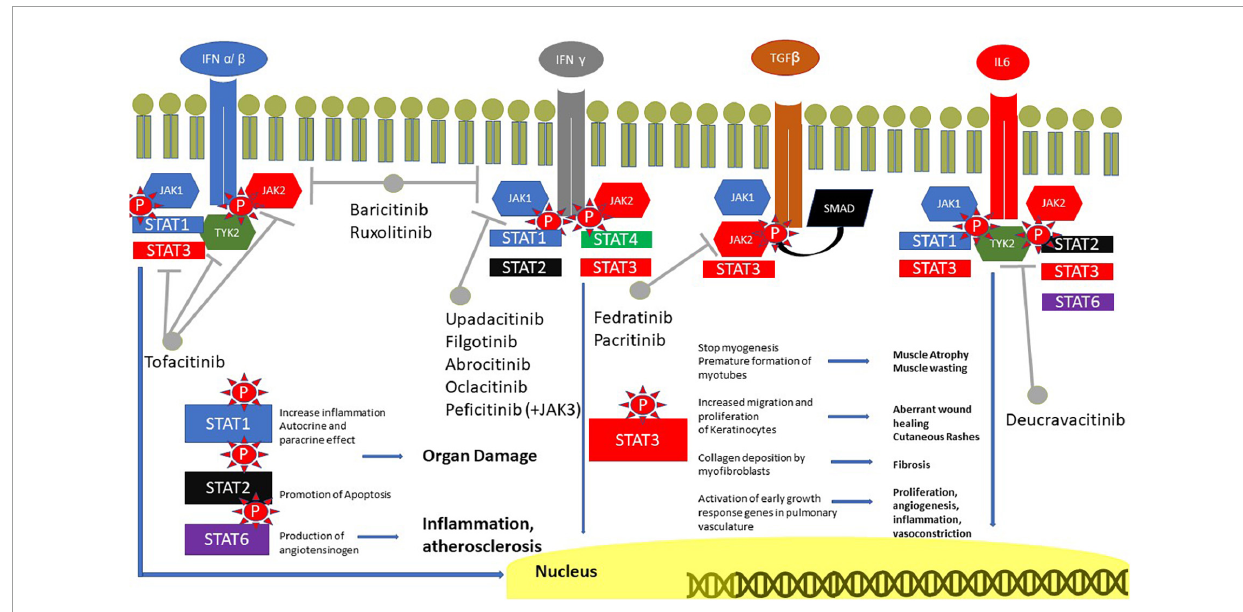
FIGURE1 Role of JAK in IIM. IFN receptors are coupled with JAK1 and 2, IFN α / β and IL6 also with TYK2. TGF β is coupled with SMAD, however, it can also phosphorylate JAK and JAK2. The signal is transmitted to the nucleus through STAT, with a great role of STAT3. STAT1 is involved in inflammation, STAT2 in the promotion of apoptosis and STAT3 in the production of angiotensinogen. JAK, Janus kinases; IFN, interferon; IL, interleukin; SMAD, suppressor of mothers against decapentaplegic; STAT, signal transducer and activator of transcription proteins; TGF, transforming growth